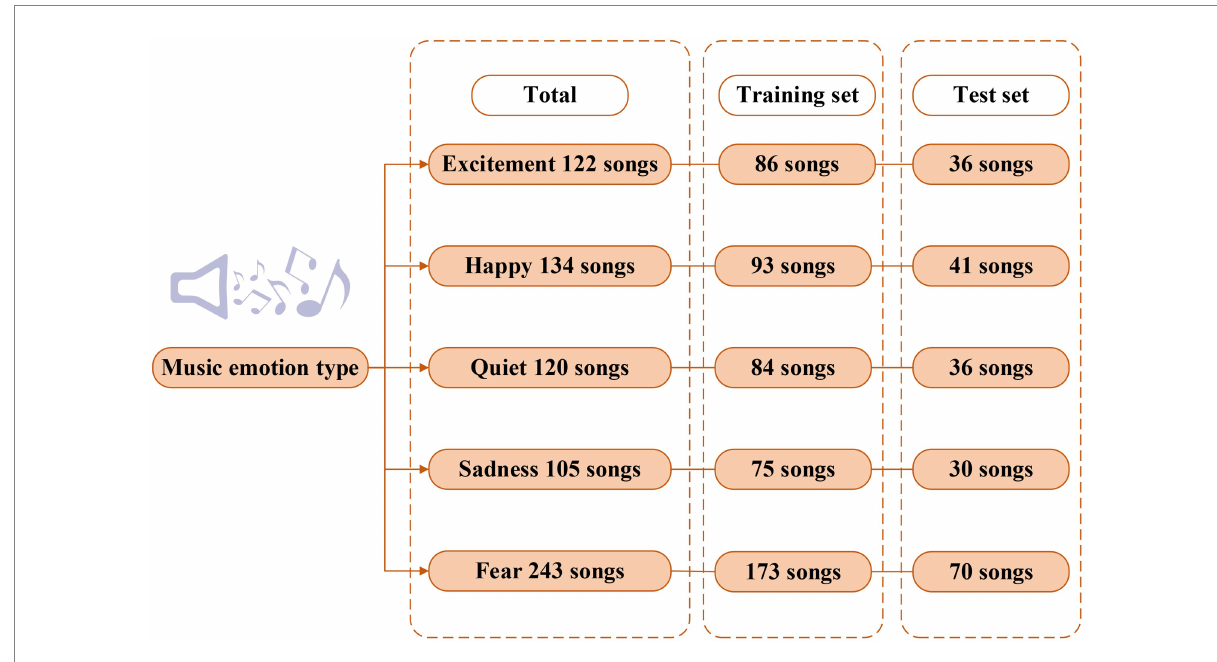
FIGURE 12 Music emotion distribution of the